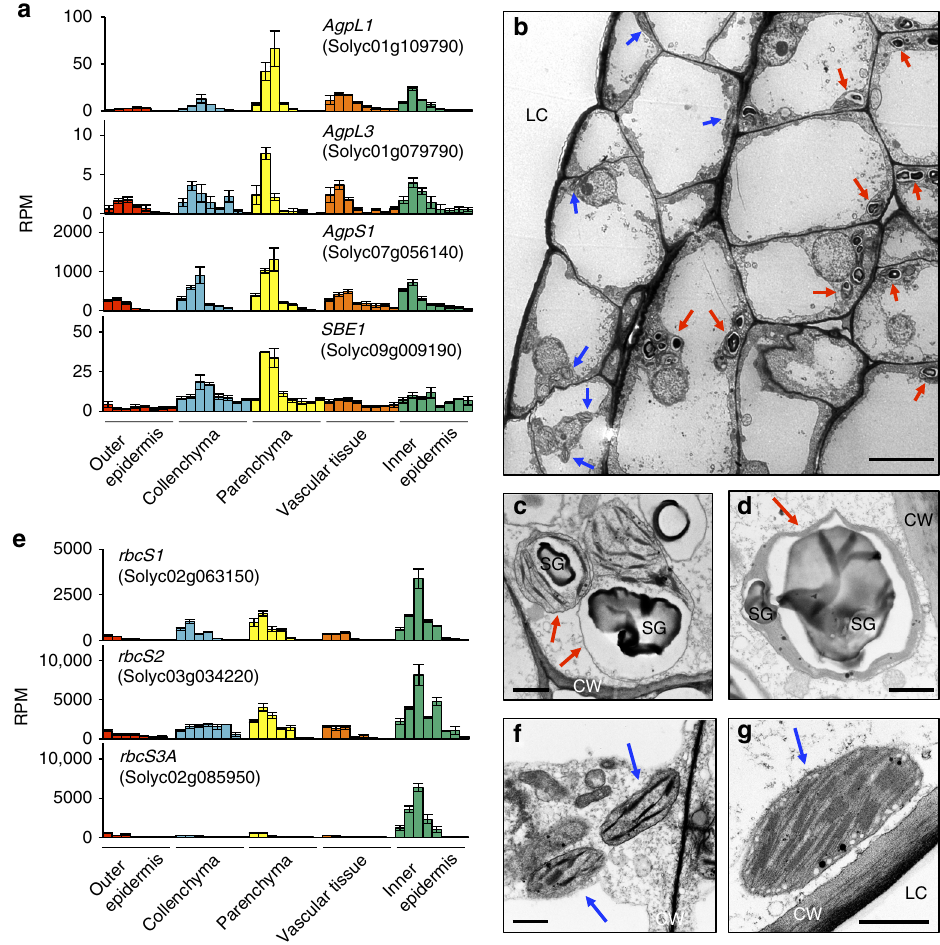
Fig. 4 Cell-type-dependent differentiation of plastids in the pericarp. a , e Expression of genes associated with starch biosynthesis ( a ) and photosynthesis ( e ). Colored bars indicate mean RPM ± s.e.m. ( n = 3) in each cell type at each stage (left to right; 5 DPA, 10 DPA, 20 DPA, MG, Br, Pk, LR, and RR). b – d , f , g Transmission electron microscopy (TEM) images show plastids in pericarp inner cell layers ( b ), parenchyma adjacent to inner epidermis ( c , d ) and inner epidermis ( f , g ). Representative images from 5 DPA ( b , c , f ) and 10 DPA ( d , g ) fruits are shown. Plastids containing starch granules are indicated by red arrows. Chloroplasts without large starch granules are indicated by blue arrows. The grana with stacked thylakoids in plastids form linear structures with a higher electron density. DPA, days post anthesis; CW, cell wall; LC, locular cavity; SG, starch granule. Scale bars: 10 μ m in b and 1 μ m in c , d , f ,